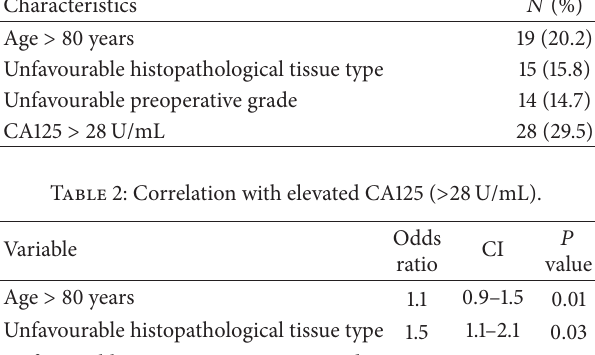
Figure 1: Kaplan Meier survival curves and dichotomized CA125